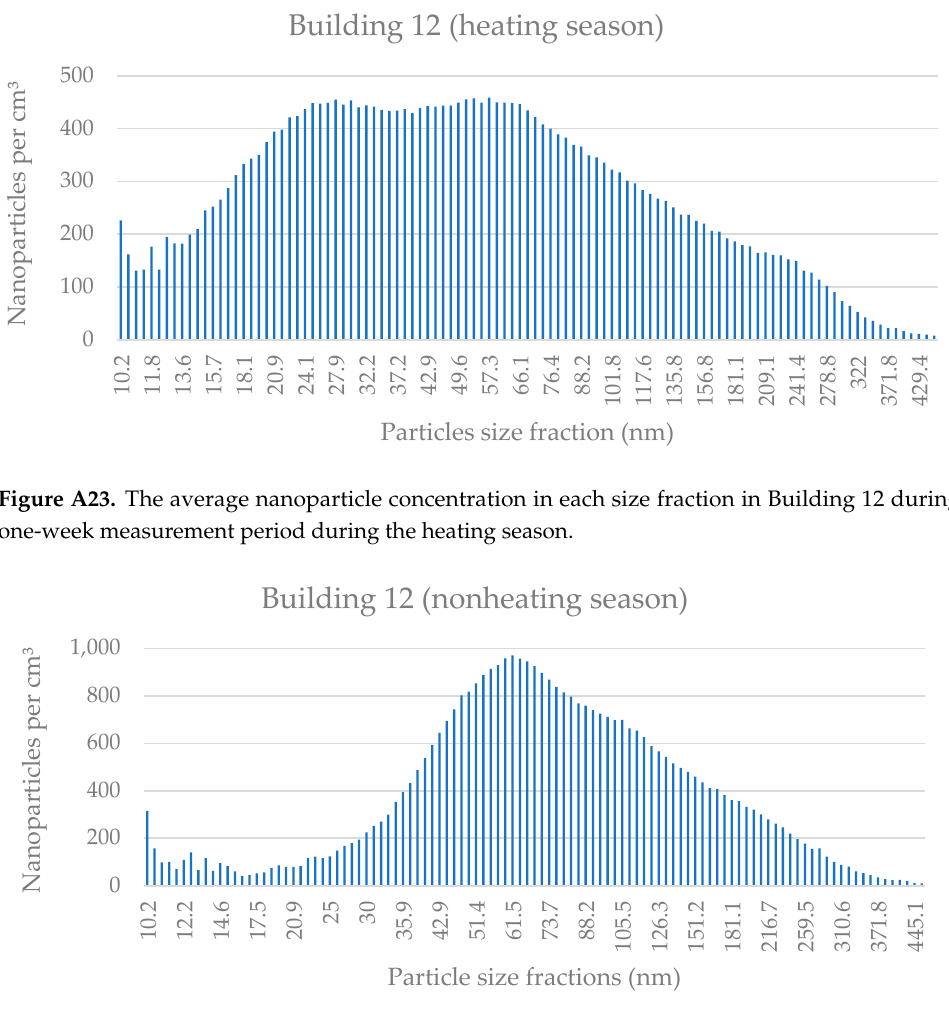
Figure A22. The average nanoparticle concentration in each size fraction in Building 11 during a one-week measurement period during the nonheating season.